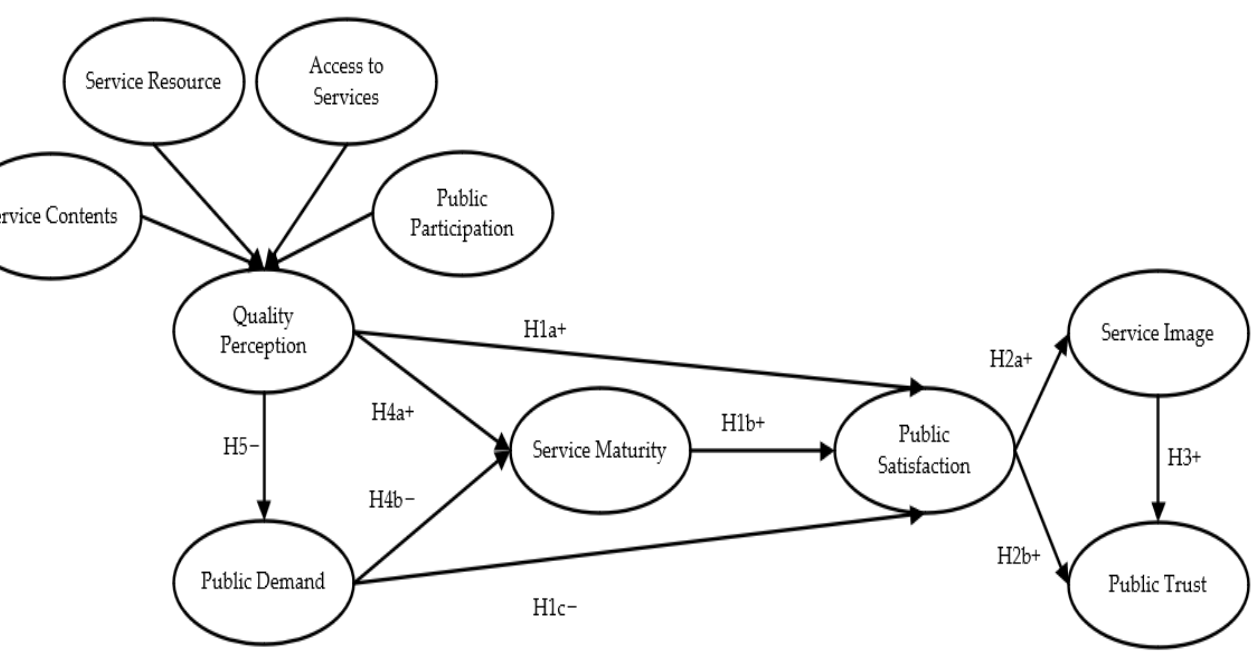
Table 5. Connotation and measurable variables of service image and public trust.